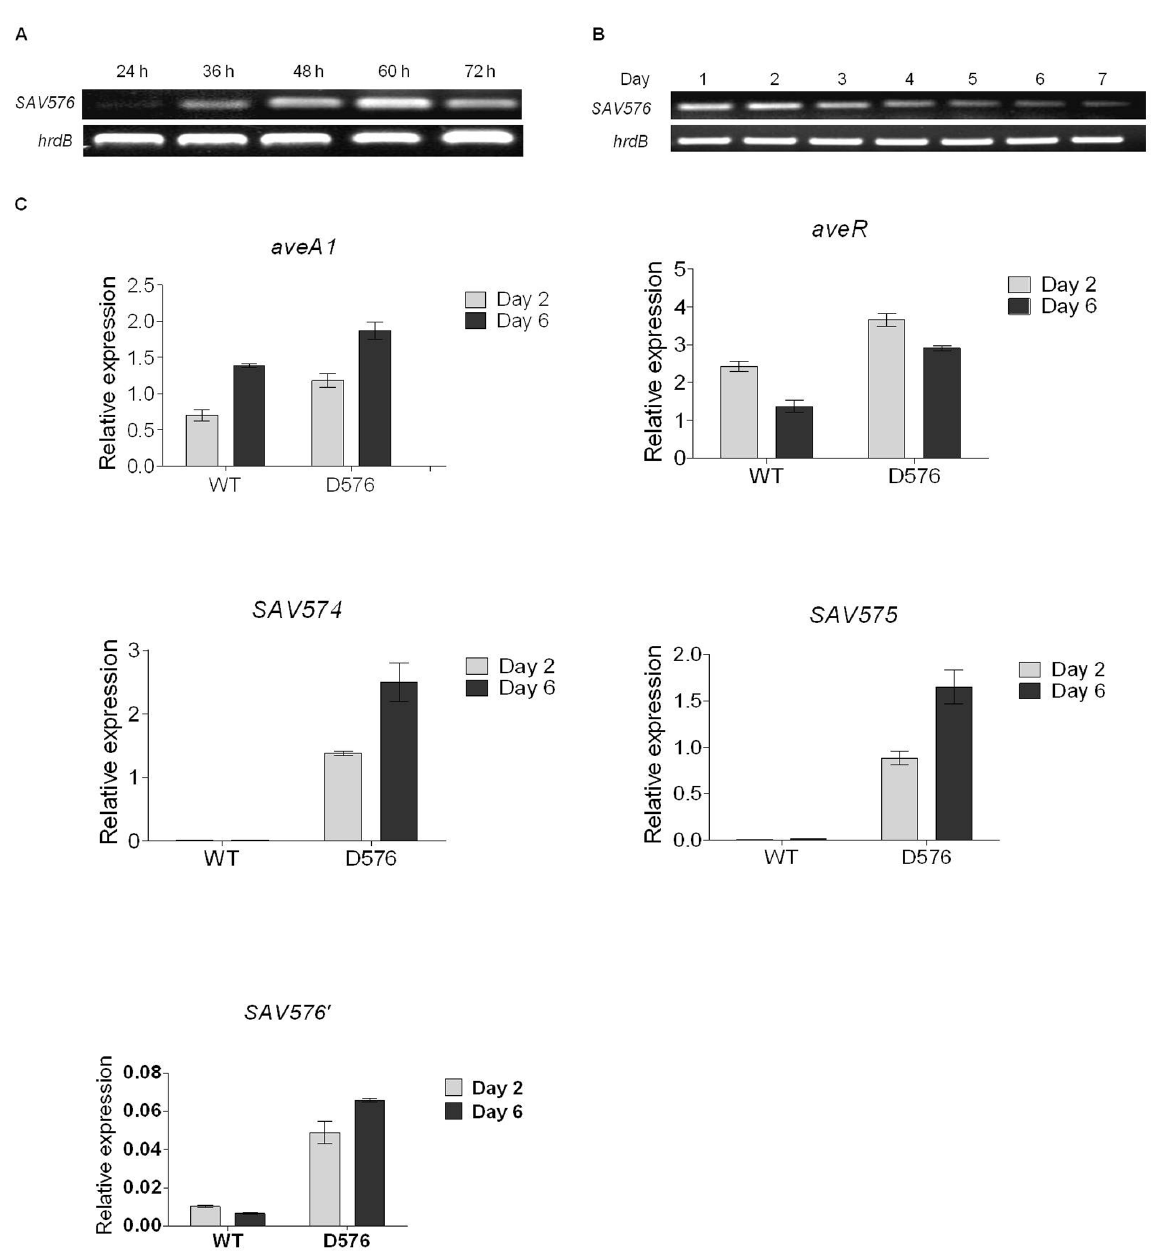
Figure 3. Transcriptional analysis of SAV576 and related genes. ( A and B ) Semiquantitative RT-PCR analysis of transcription levels of SAV576 in ATCC31267 grown on solid medium YMS ( A ) and in liquid medium FM-II ( B ) for various durations. The 214-bp SAV576 transcript was amplified from the internal coding region of SAV576 with primers GJ83 and GJ84. hrdB was used as a positive internal control. ( C ) Real-time RT-PCR analysis of aveR , aveA1 , SAV574 , SAV575 and SAV576 transcription levels from ATCC31267 (WT) and D576 grown in FM-II on days 2 and 6. Relative values were obtained using hrdB as a reference. SAV576 9 , 142-bp transcript amplified from the SAV576 promoter region and the remainder ORF of D576 with primers GJ46* and